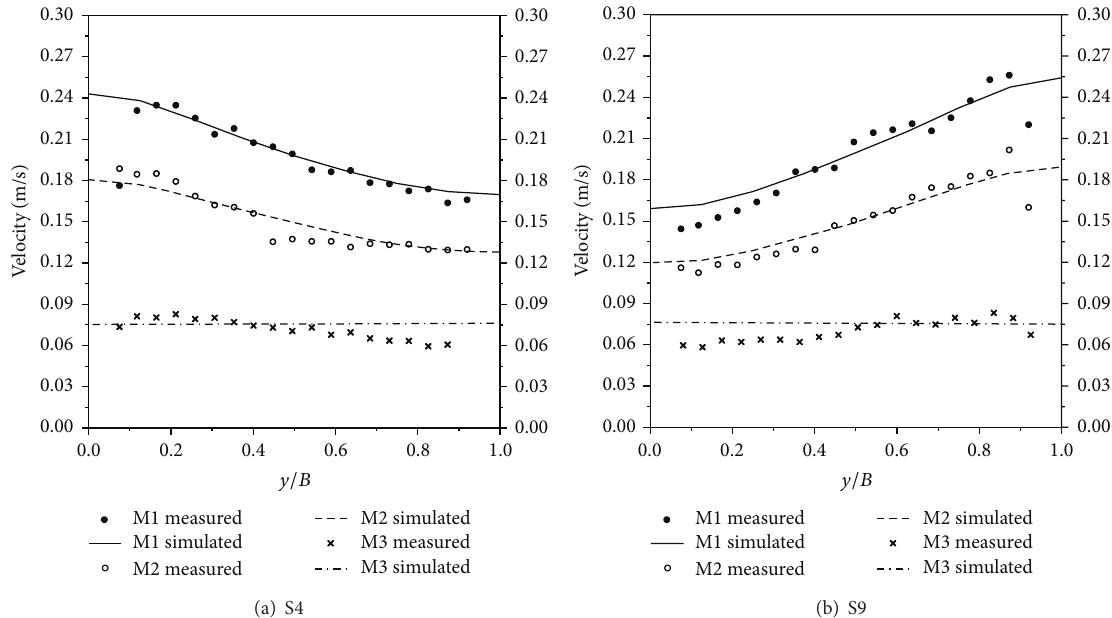
Figure 5: Comparison of transverse velocity distributions for meandering channel flow at the apices of the bends.